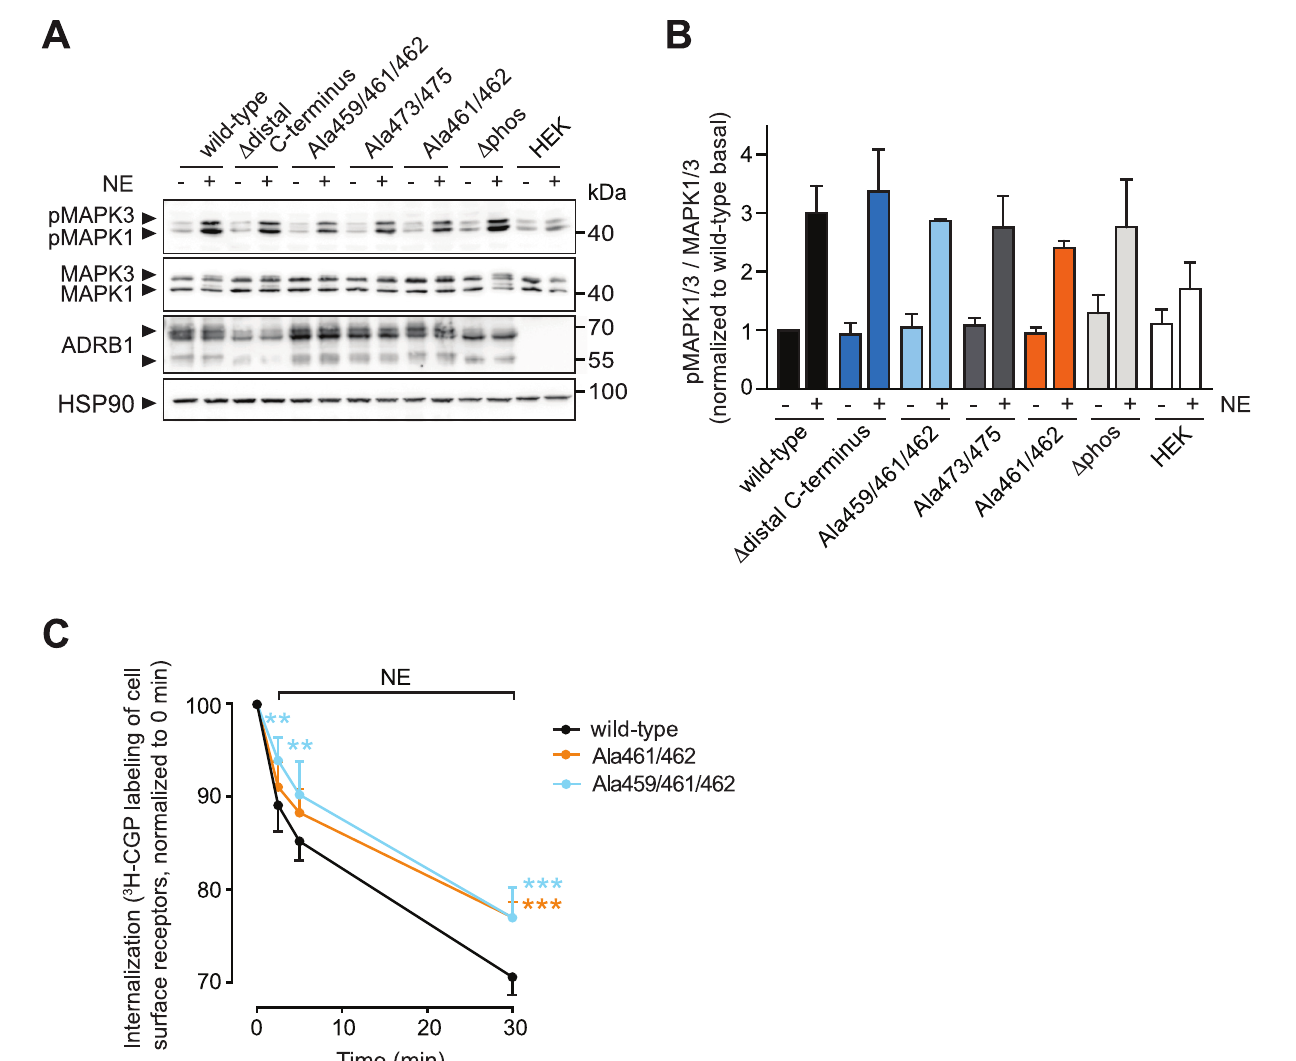
Fig 4. Phosphorylation at the distal C-terminus of the ADRB1 determines receptorinternalization, but does not alter stimulation- dependent MAP kinase activation. ( A ) Representative Western blots using antibodies directed againstactivated MAPK1/3 (pMAPK1/3), MAPK1/3 and ADRB1. HSP90 was used as a loadingcontrol. Lysates were preparedfrom HEK293cells stably expressingthe indicated ADRB1 mutants and stimulatedwith NE (100 μ M for 5 min) or control. ( B ) Quantification of MAPK1/3 activity from (A). Data are means+SEM, n = 3–9. ( C ) Internalization of ADRB1 mutants expressedin HEK293 cells (together with ARRB2) as determinedby loss of cell surface receptorlabelingwith 3 H-CGP-12177. Time points indicate durationof treatment with NE prior to labelingwith 3 H-CGP-12177. Data are means+SEM of n = 5 independentexperiments. ** p (cid:20) 0.01, *** p (cid:20) 0.001 as determined by two-way